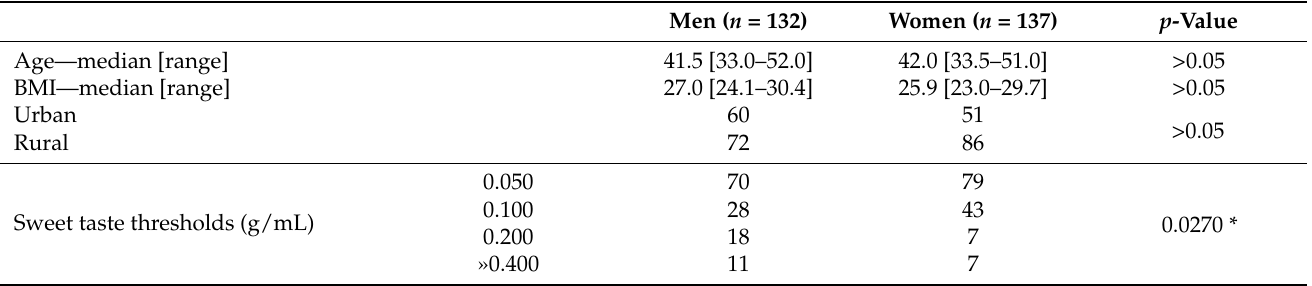
Table 2. Participants’ characteristics and anthropometric